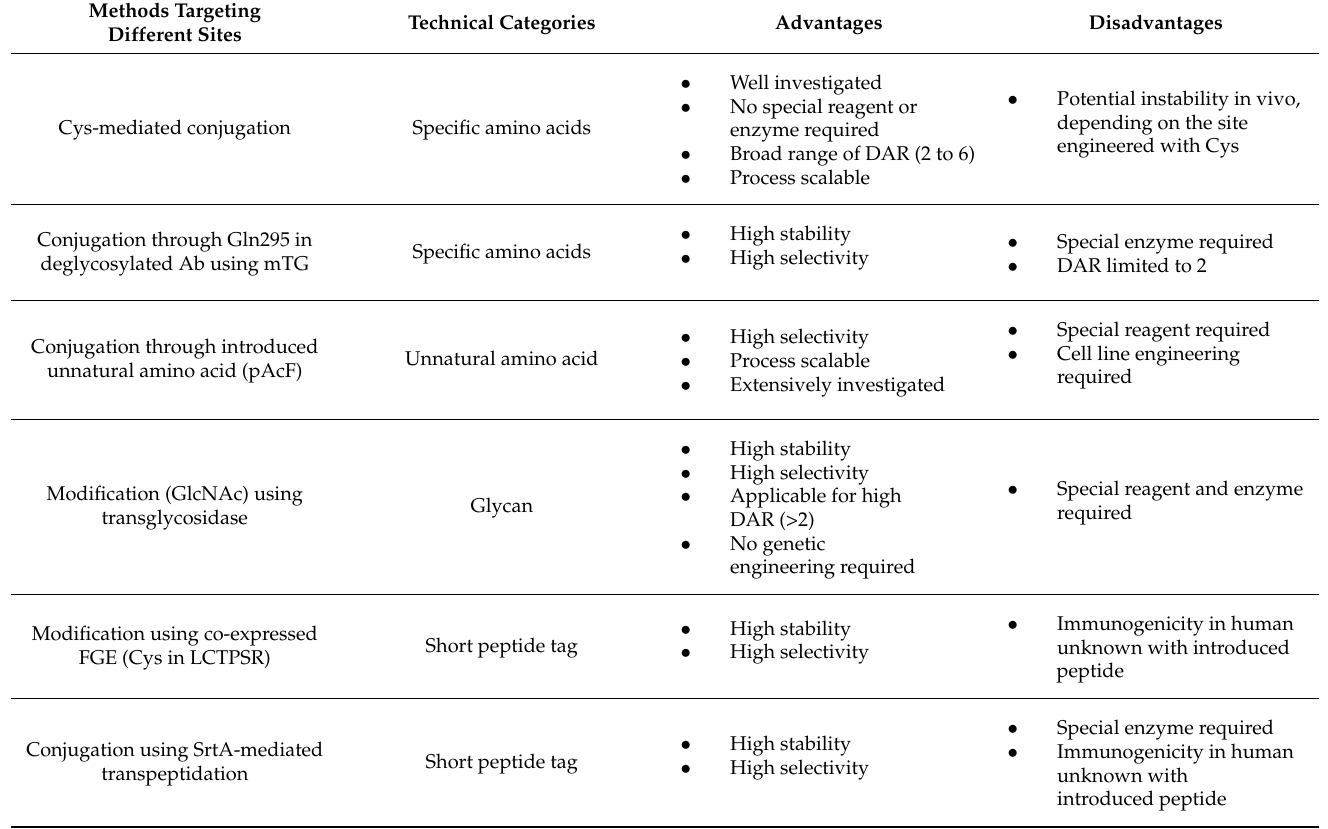
Table 5. The advantages and disadvantages of major site-specific conjugation methods for payloads other than synthetic